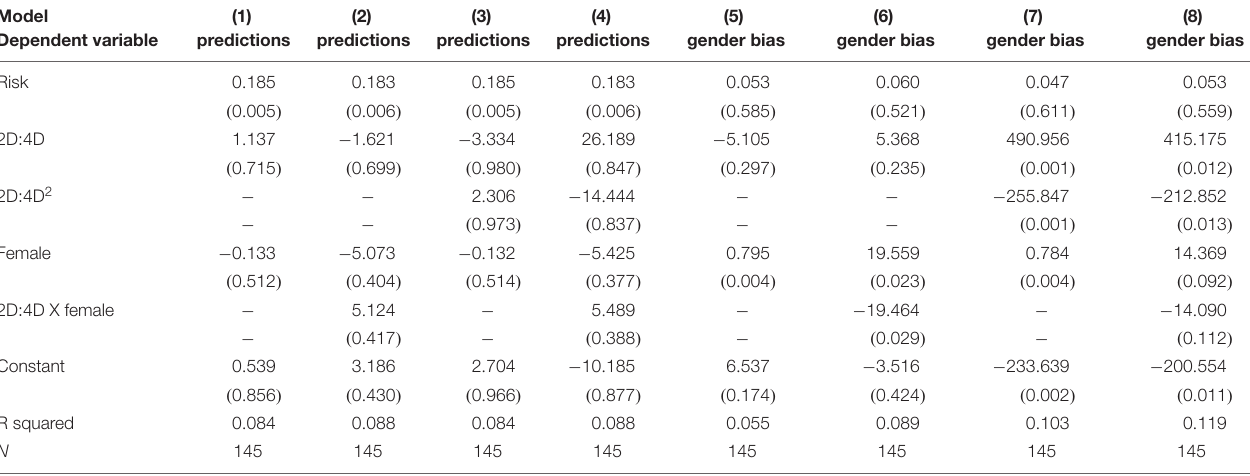
TABLE 4 | Regression analysis of right hand 2D:4D, risk predictions and gender bias in predictions. Model Dependent variable